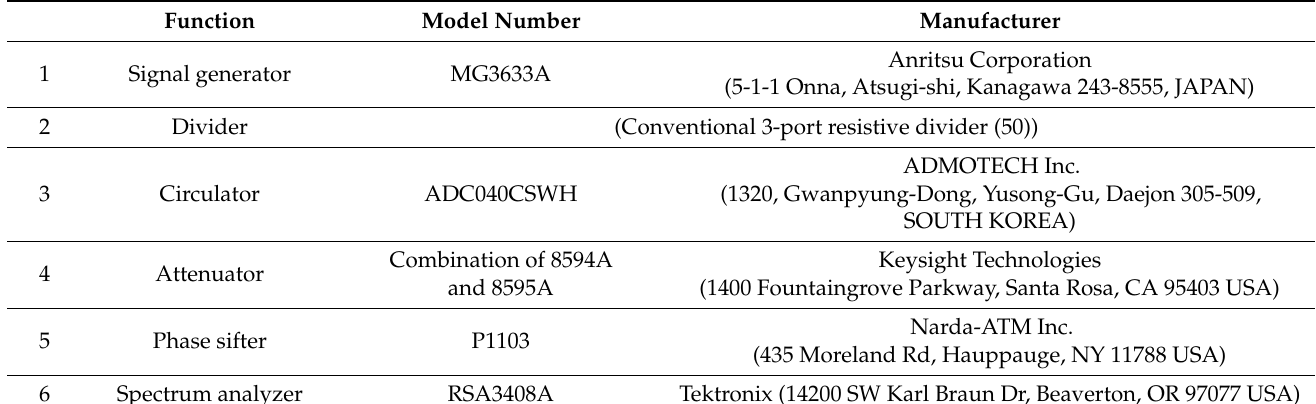
Figure 19. Enlarged view of the carrier-suppressing circuit connected with the sensor.